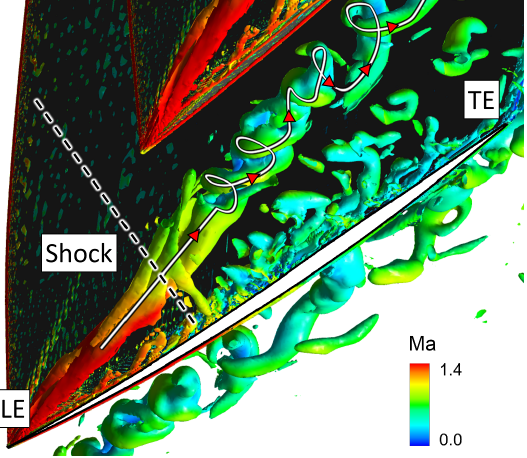
Figure 18. Sketch for spiral-type breakdown of TLV at NS.